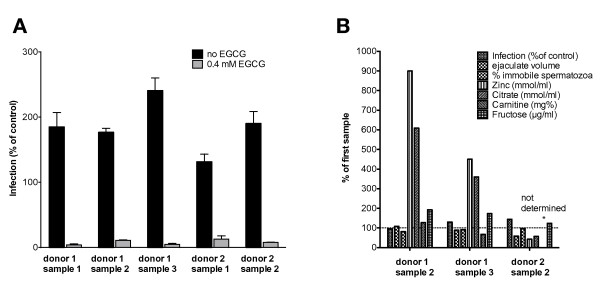
Variation of infectivity enhancing potential and clinical parameters of semen between different samples from identical donors. Semen samples from two healthy donors were analyzed longitudinally. A) Infectivity modulation in relation to control infections without semen in experiments in absence (black bars) or presence (grey bars) of EGCG as percentage. Shown are mean values of quintuplicate infections and standard error of the means. B) Changes of infectivity modulation and clinical semen parameters in semen samples from the same donors. The Y-axis denotes values for follow-up samples relative to baseline values.